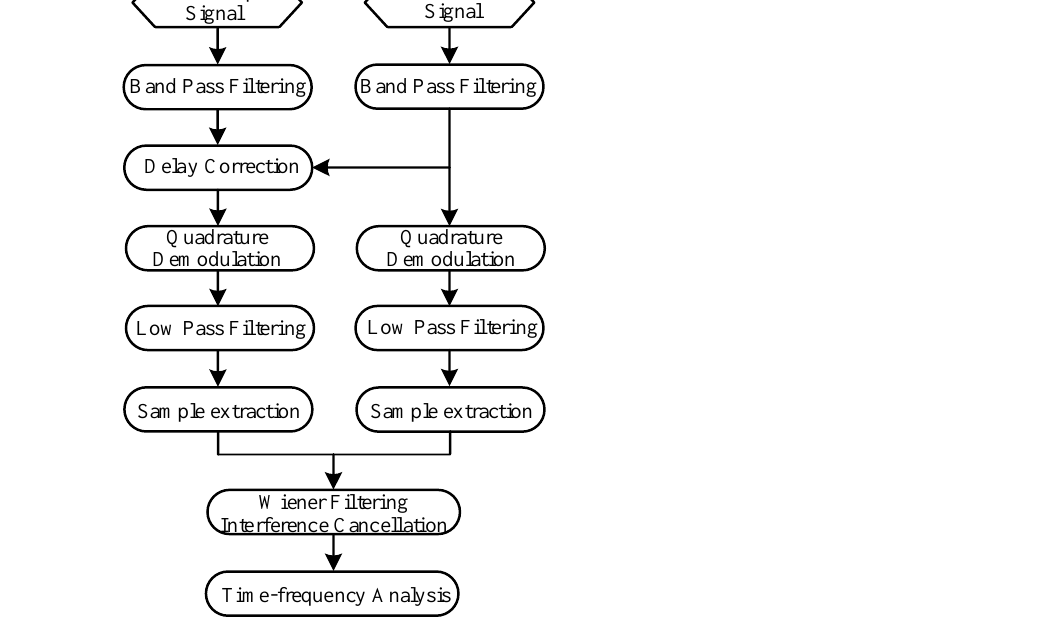
Figure 13. The signal processing scheme for achieving the NMR signal of the NSS-NMR effect.